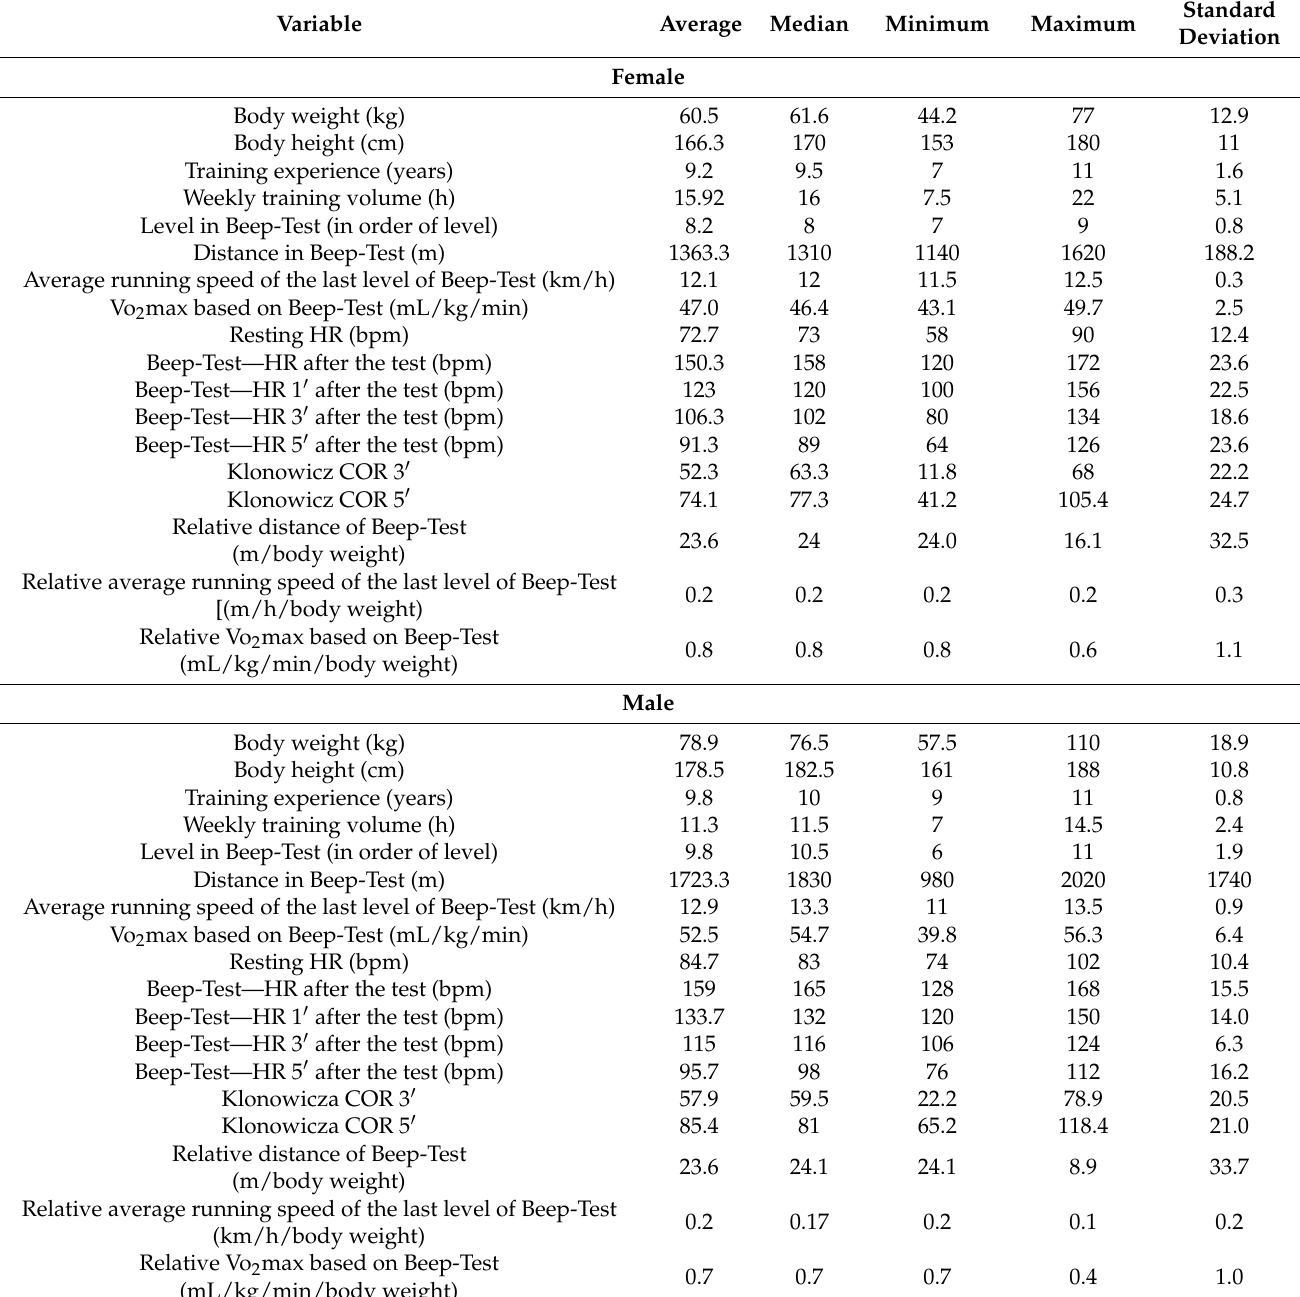
Table 1. Body weight, body height, training experience, weekly training volume, Beep-Test scores, and COR of female and male judo cadet national team athletes